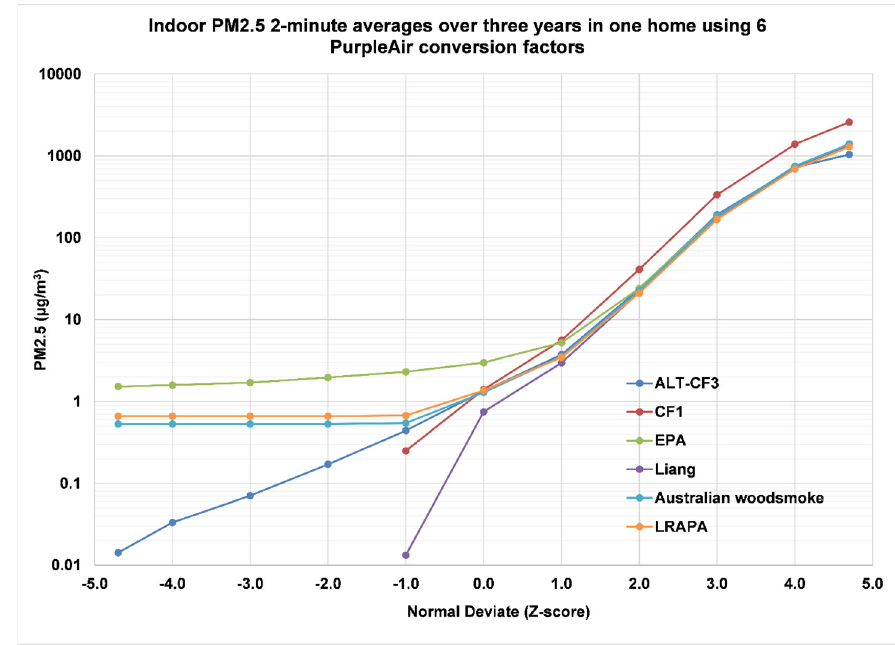
Figure 18. Comparison of 6 algorithms for determining PM 2.5 estimates.